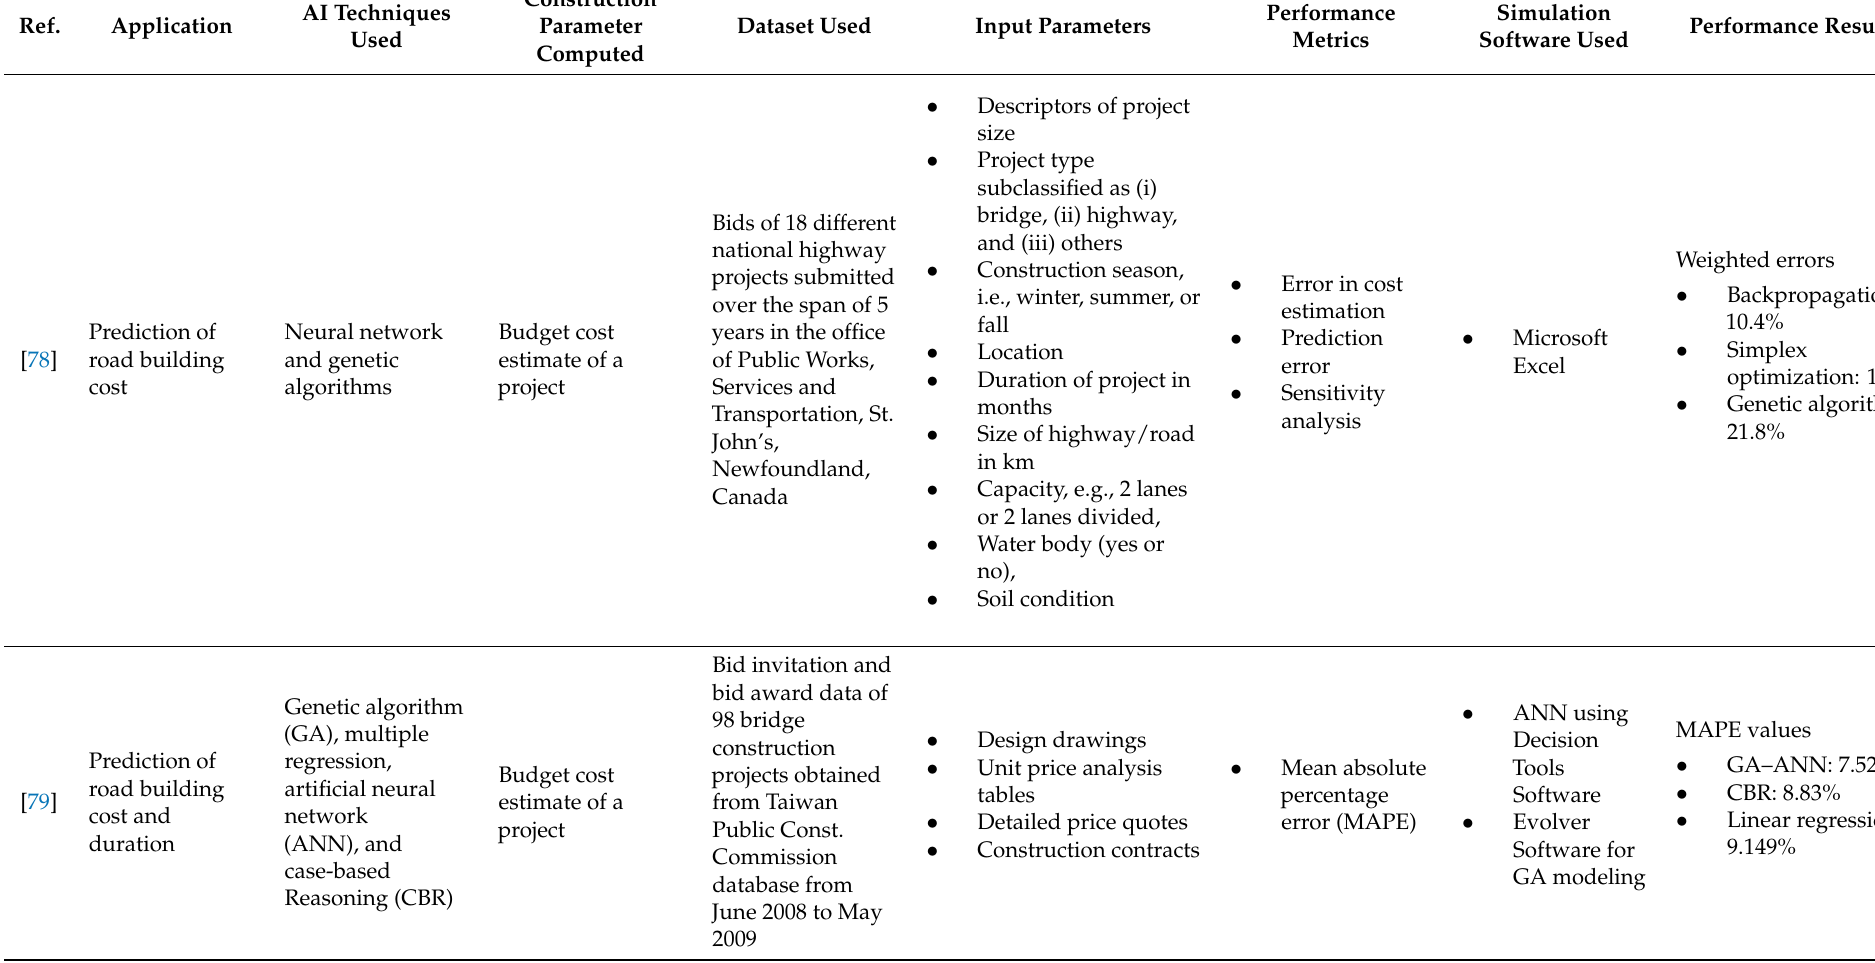
Table 4. Artificial intelligence for project cost estimation.